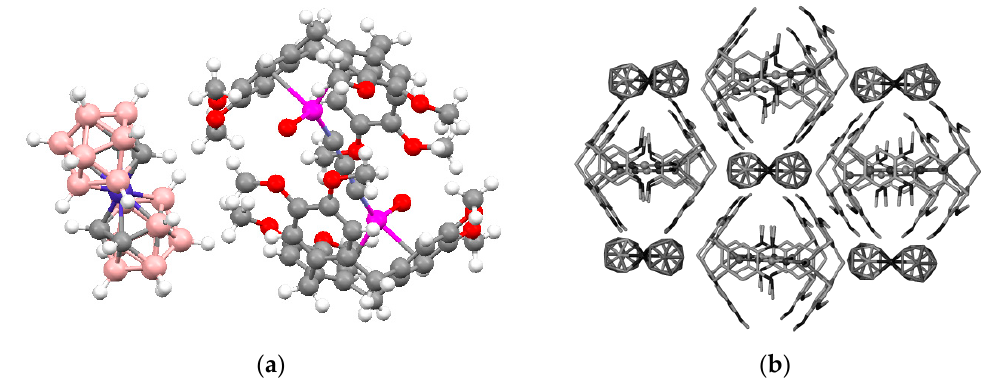
Figure 113. X-ray structure of [Ag(MeCN)(H 2 O)(CTV) 2 ][3,3’-Co(1,2-C 2 B 9 H 11 ) 2 ]: coordination arrangement of silver cation ( a ) and crystal packing ( b ). Reprinted with permission from reference [122]. Copyright © (2003) American Chemical